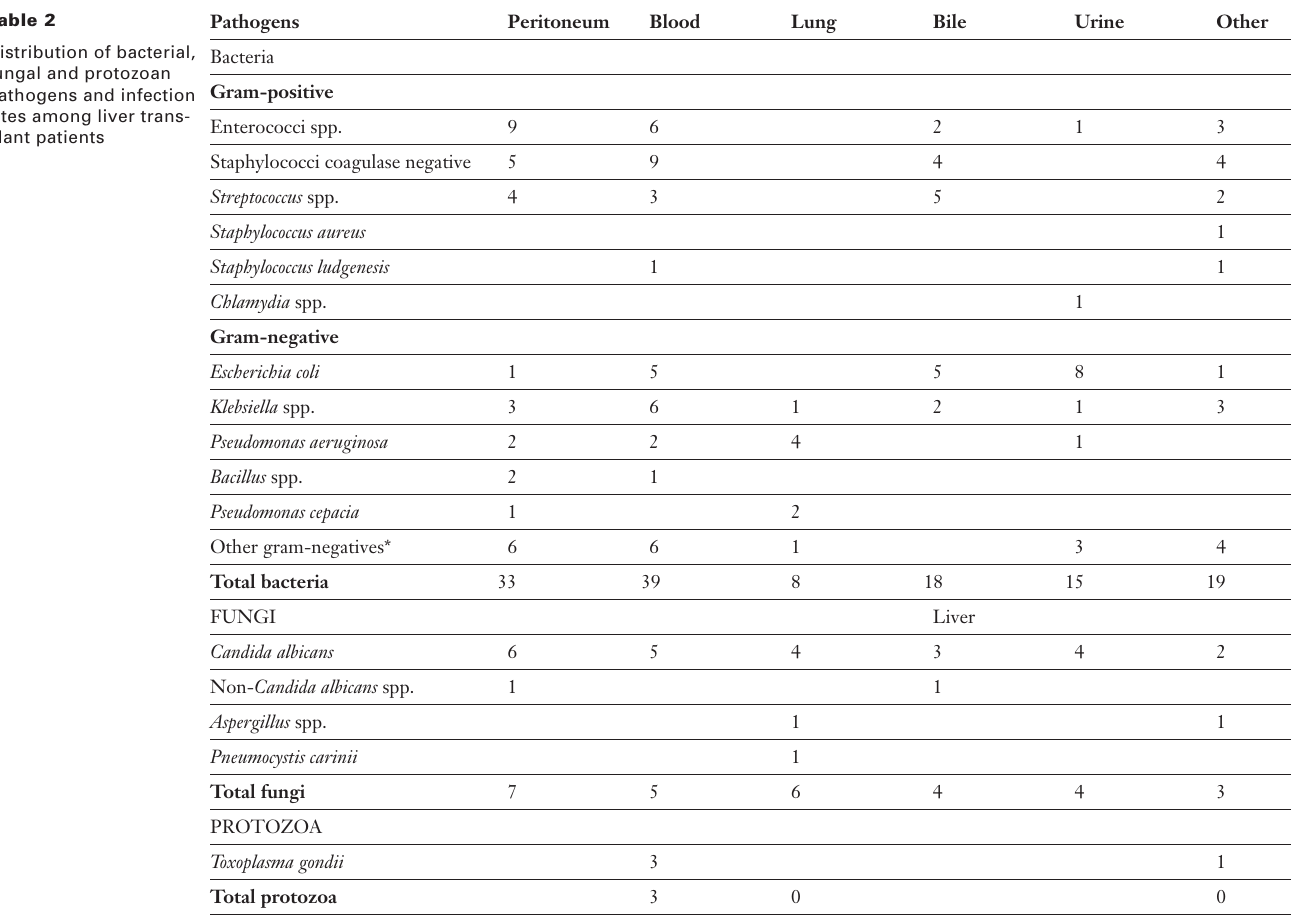
Figure 2 Thirty-day relation- ship of new infection episodes both before and after rejection diagnosis. Infectious episodes reported in the 30-day period preceding or follow- ing a rejection episode treated with steroids: F , bacterial (17 episodes/ 12 patients); n , viral (28 episodes/ 23 patients); s , fungal (5 episodes/ 5 patients).